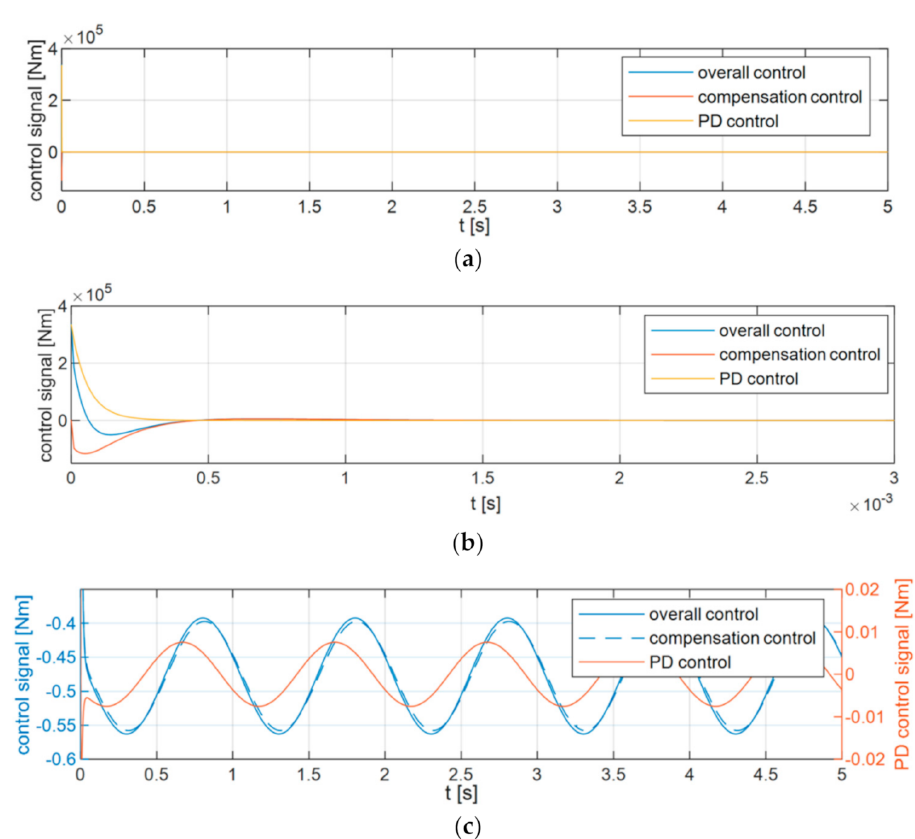
Figure 14. Control signals: ( a ) overall control system and control signal components; ( b ) control during the initial phase of gait; ( c ) control graph with customized scales.